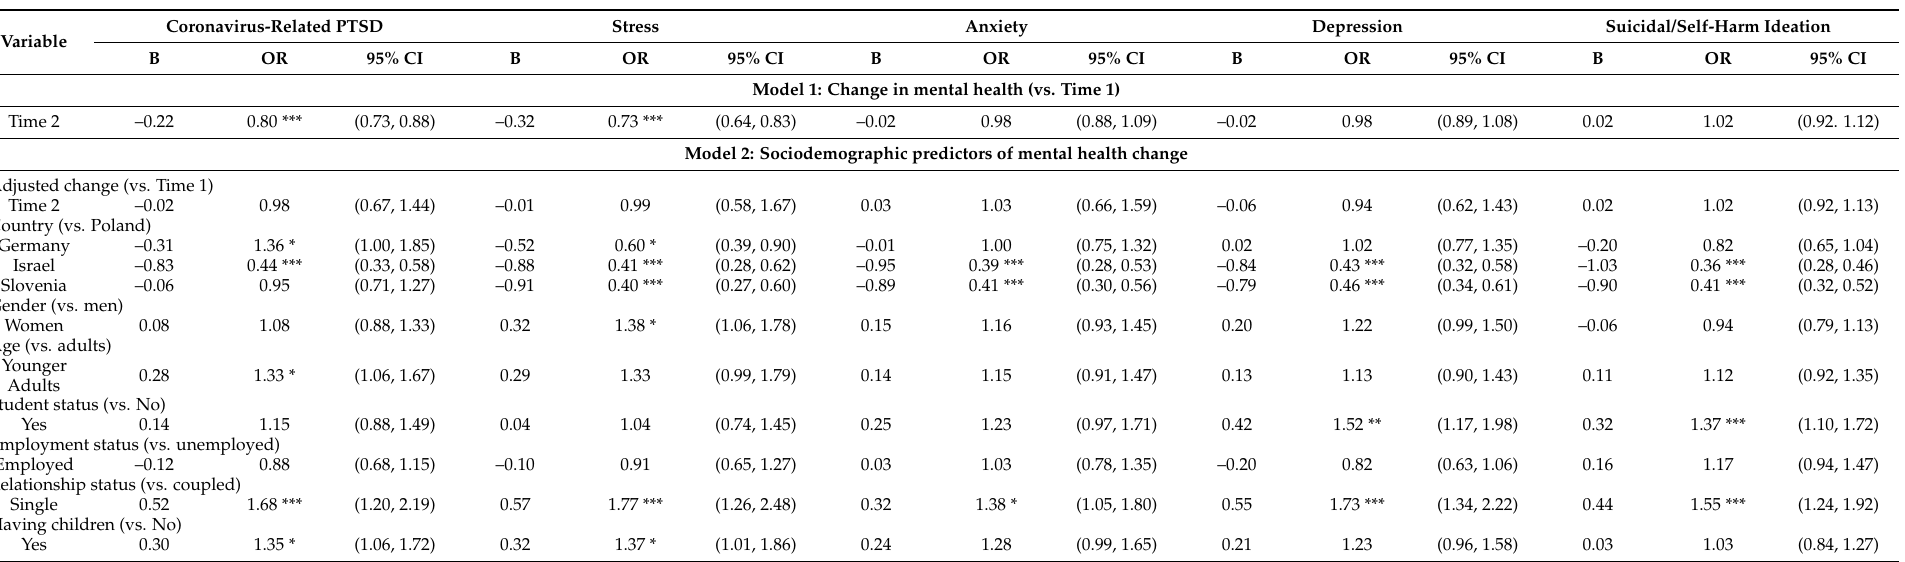
Table 3. Longitudinal predictors of coronavirus-related PTSD, perceived stress, anxiety, physical activity, depression, and suicidal